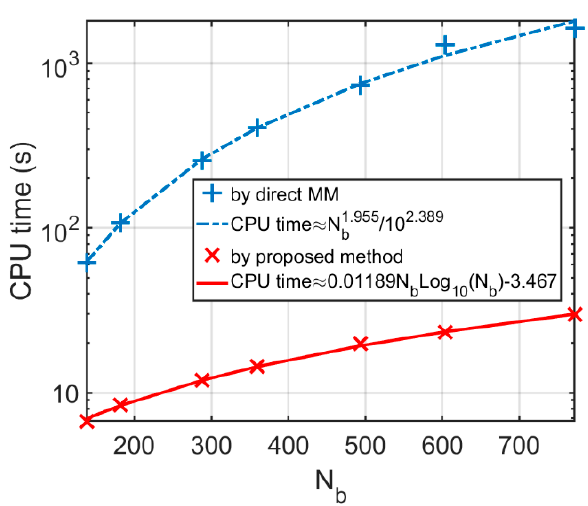
Figure 7. CPU time consumption versus N b for the values of CPU time and N b shown in Table 2 for both direct and proposed methods. The fitted least square models are also shown.